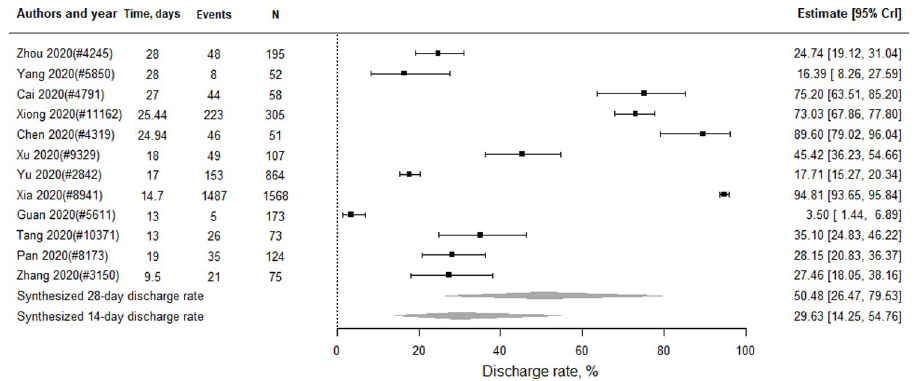
Fig 4. Discharge rate for severe or critical COVID-19 patients in China.